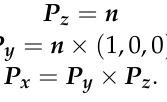
Figure 5. Schematic diagram of complex hole-detection. A complex hole consisting of three simple holes (purple, bule and yellow) via connected by a non-manifold vertex V 0 . The half-edges are represented by directed line, and the three green half-edges ( HE2 , HE3 , HE4 ) are the extended candidates of the red half-edge HE1 . The green dotted lines ( Sg1 , Sg2 , and Sg3 ) are the auxiliary segments used to determine the intersection.